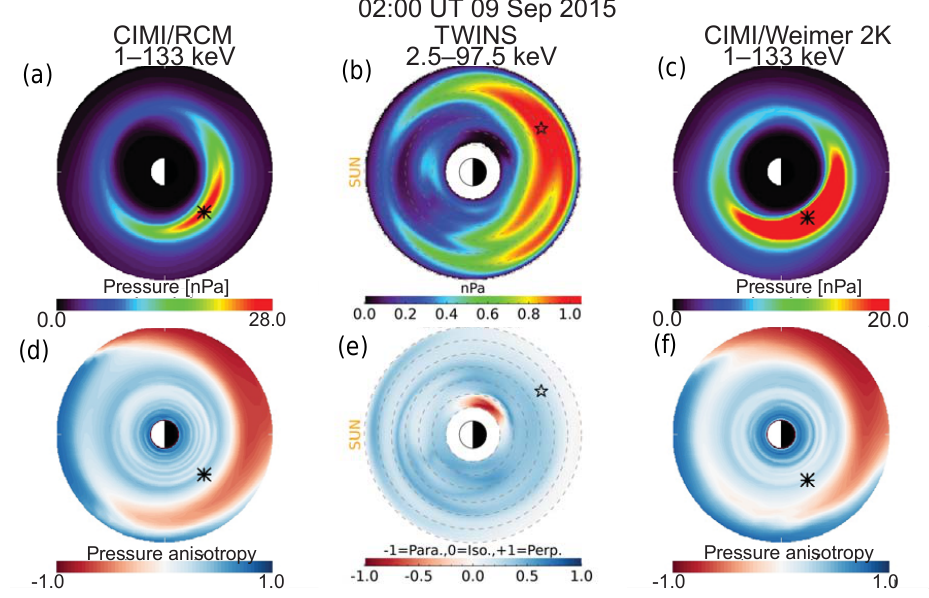
Figure 6. The ion equatorial pressure and pressure anisotropy for 02:00UT 9 September 2015 in the same format as Fig.